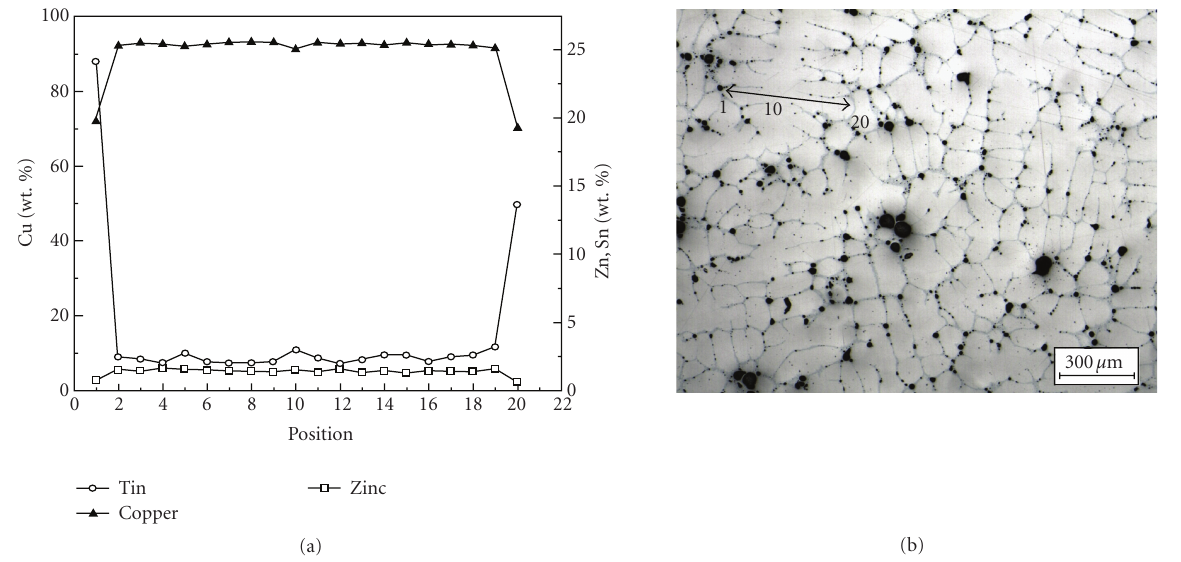
Figure 6: (a) Composition profile through a dendrite cross section in Cu-5Sn-5Zn-5Pb alloy that was quenched after the primary solidification. (b) Micrograph of a dendrite cross section in Cu-5Sn-5Zn-5Pb alloy that was quenched after the primary solidification.